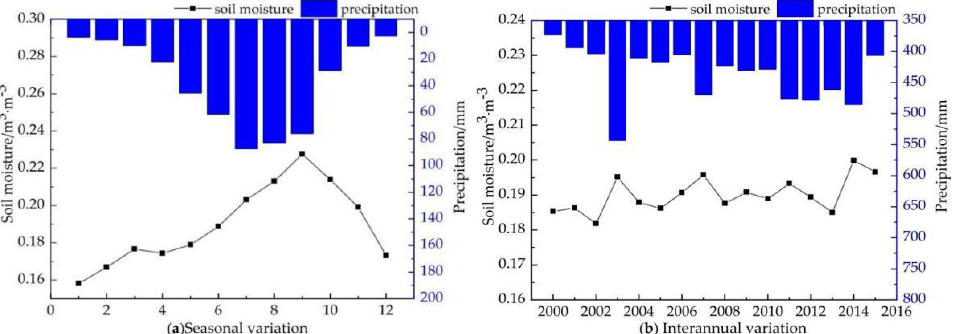
Figure 10. Seasonal and interannual variation of SM and precipitation in the Yellow River Basin, 2000 to 2015: ( a ) Seasonal variation, ( b ) Interannual variation